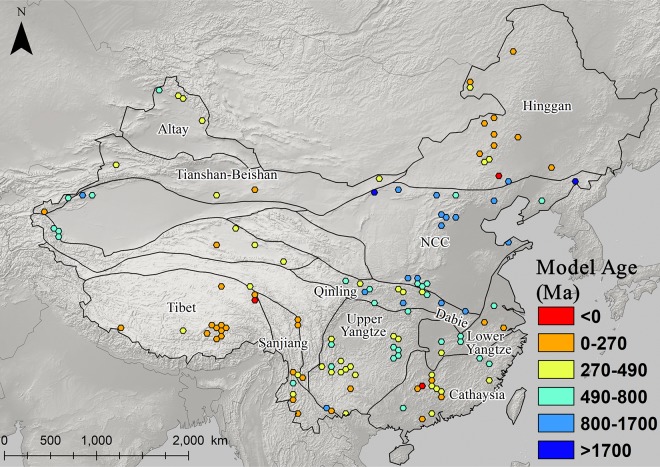
Map of 238U/204Pb ratios for galena ores (n = 2,104).